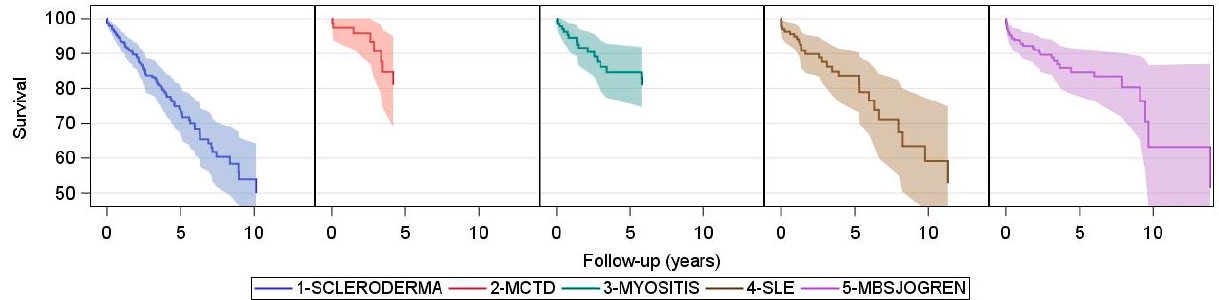
Figure 4. Survival in CTD-ILD. Kaplan–Meier survival curves for each CTD-ILD subtype with adjustment for age. Time origin is the date of ILD diagnosis. Shaded areas represent 95% confidence intervals.